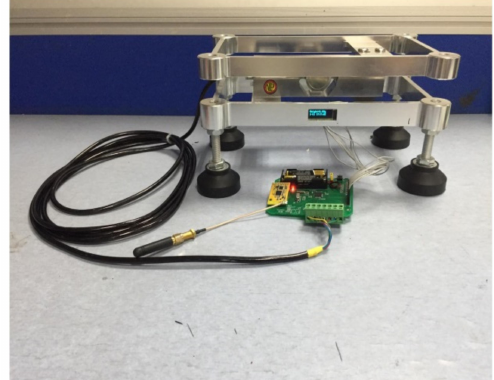
Figure 4. Hardware structure diagram of